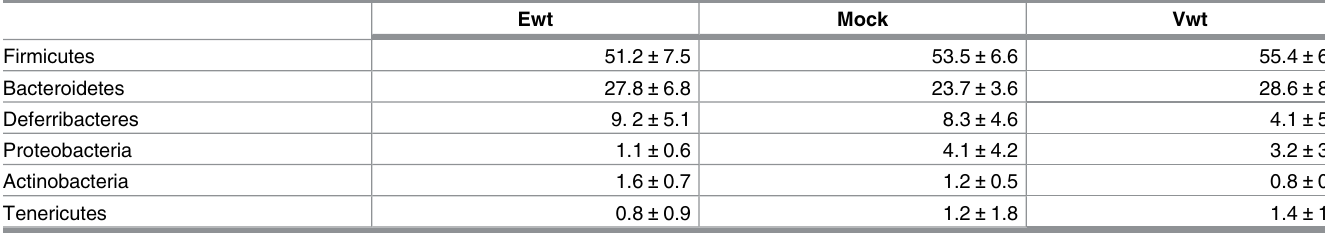
Table 2. Relative abundance (%) of major bacterial groups for Mock, ECTV and VACV infections. ± represent SD.